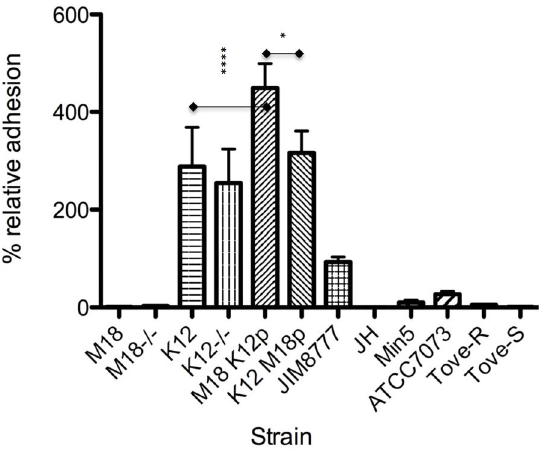
Figure 6. Relative adhesive abilities of Streptococcussalivarius strains to HEp-2 cells with different megaplasmid combina- tions. (Error bars denote 6 SD, the method of Turkey was used for multiple comparisons (*p , 0.05, **p , 0.01, ***p , 0.001) and signifi- cance shown where the K12 megaplasmid was inserted into non adherent M18 strain.